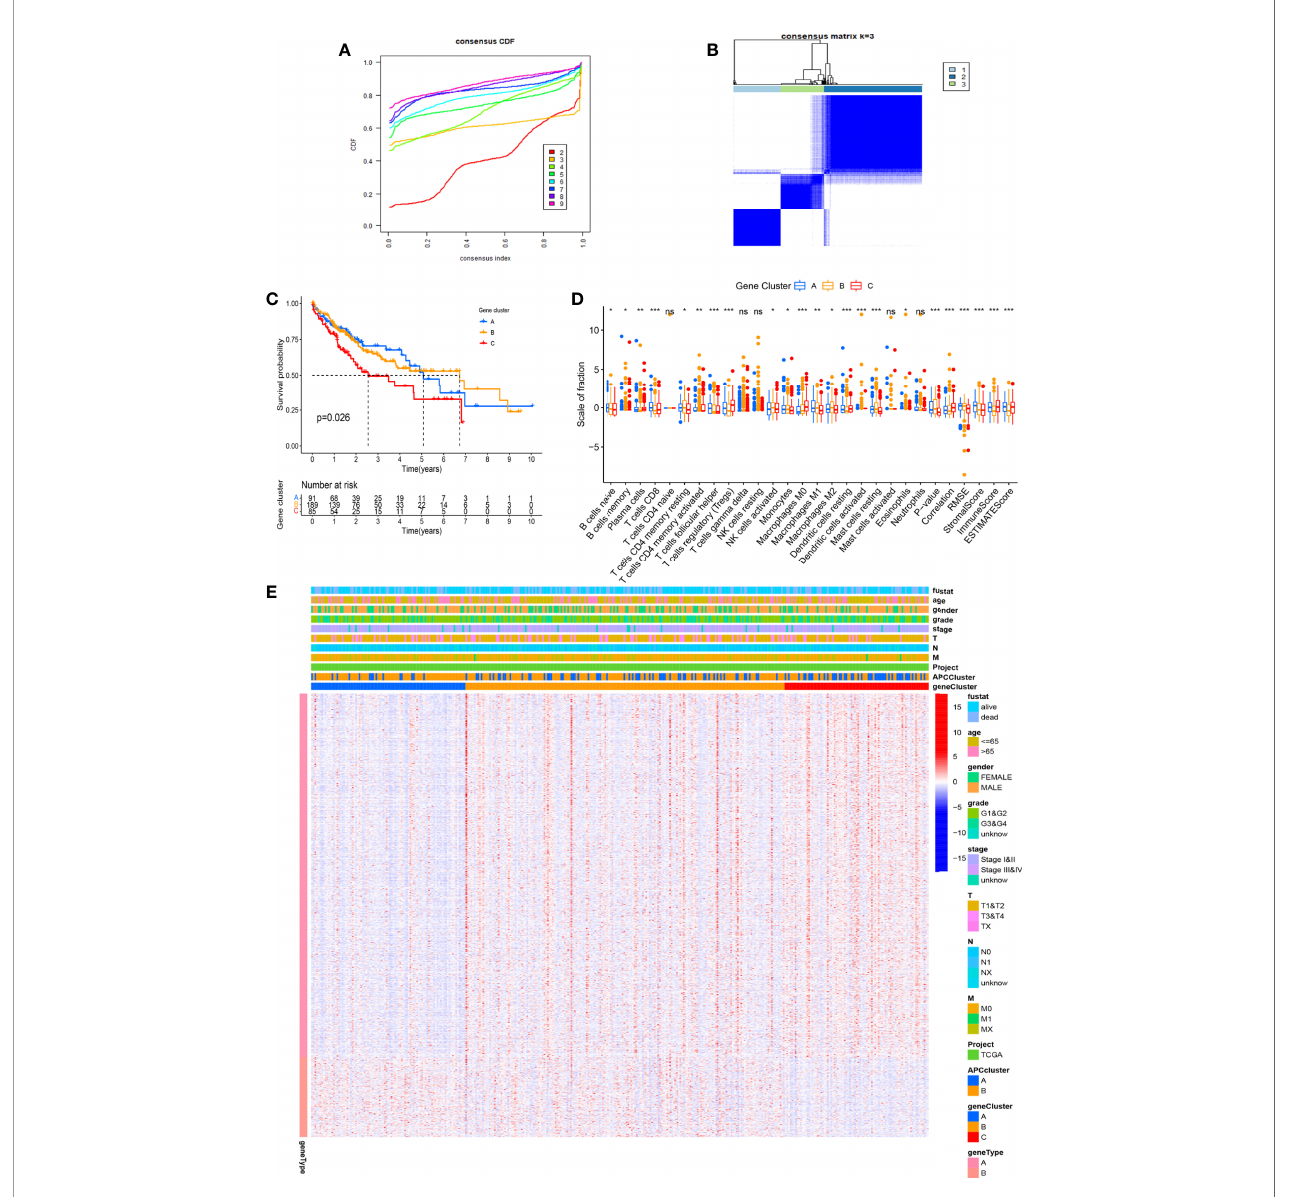
FIGURE 5 | Identi fi cation of main genomic subtypes according to the antigen-presenting cell (APC) clusters. (A) Identi fi cation of the optimal k value in the consensus clustering (k = 3). (B) Expression distribution of different subtypes when consumption index k = 3. (C) The Kaplan – Meier (K-M) survival curve of 3 genomic clusters (p = 0.026). (D) The boxplot displays the difference between 22 tumor-in fi ltrating immune cells (TICs) among different genomic subtypes. (E) The complex heatmap shows the difference in clinical characteristics and differentially expressed gene (DEG) expression levels among different APC clusters. *p < 0.05, **p < 0.01, ***p < 0.001. ns, no signi fi